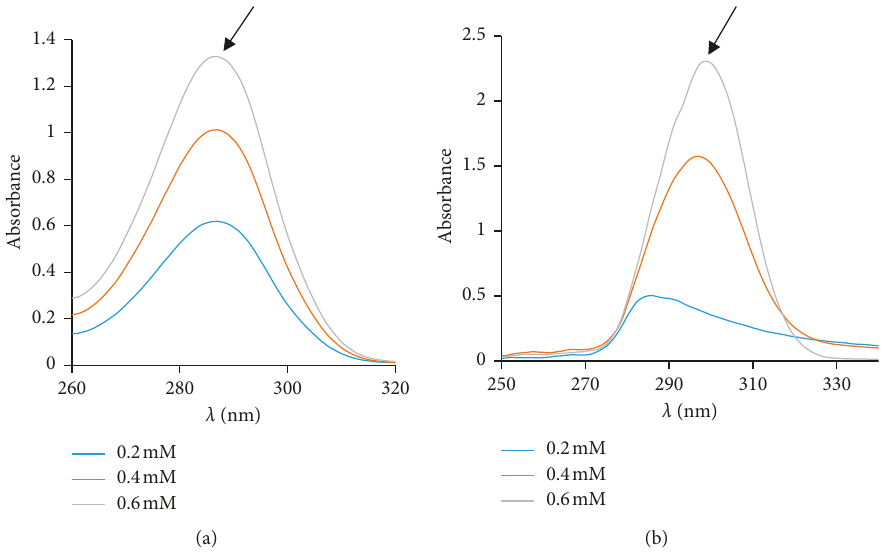
Figure 4: UV absorption spectra of 2-aminophenol in (a) methanol and (b) DMSO with arrows indicating the λ 00.511.522.533.544.5